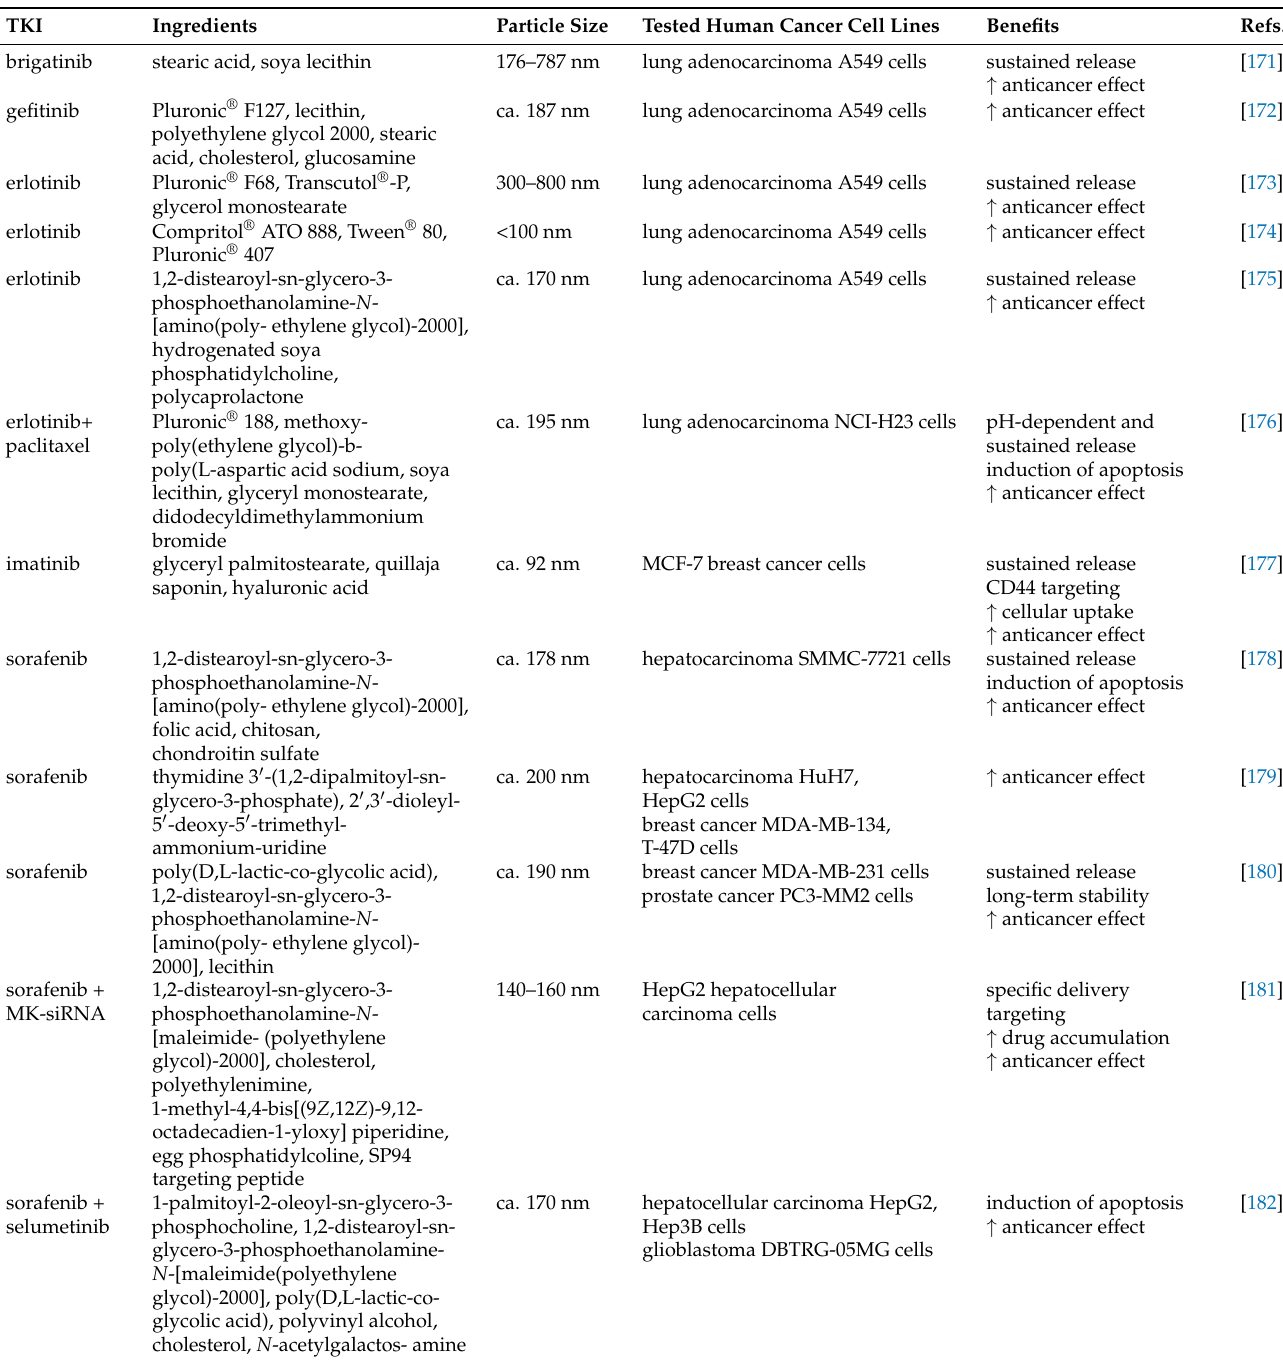
Table 4. In Vitro tested SLN-based TKI